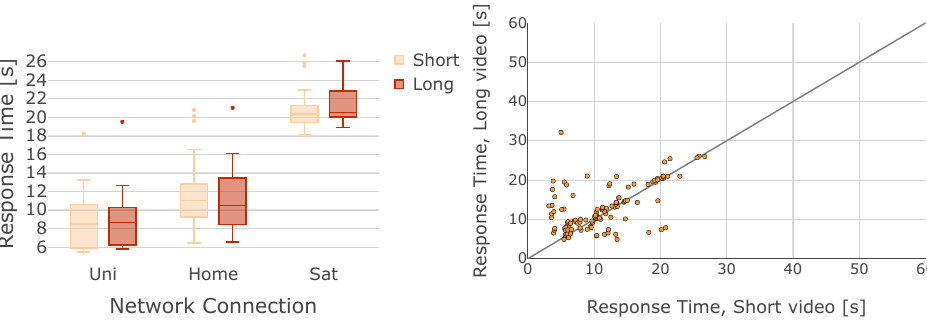
Figure 11. Response time using the UNI, HOME and SAT network connections, in case of video files hosted locally on the client, with different video lengths (short and long) and the same size. A scatter plot to validate the last consideration was considered, in which observations with the same combination of variables, except the video length, are coupled